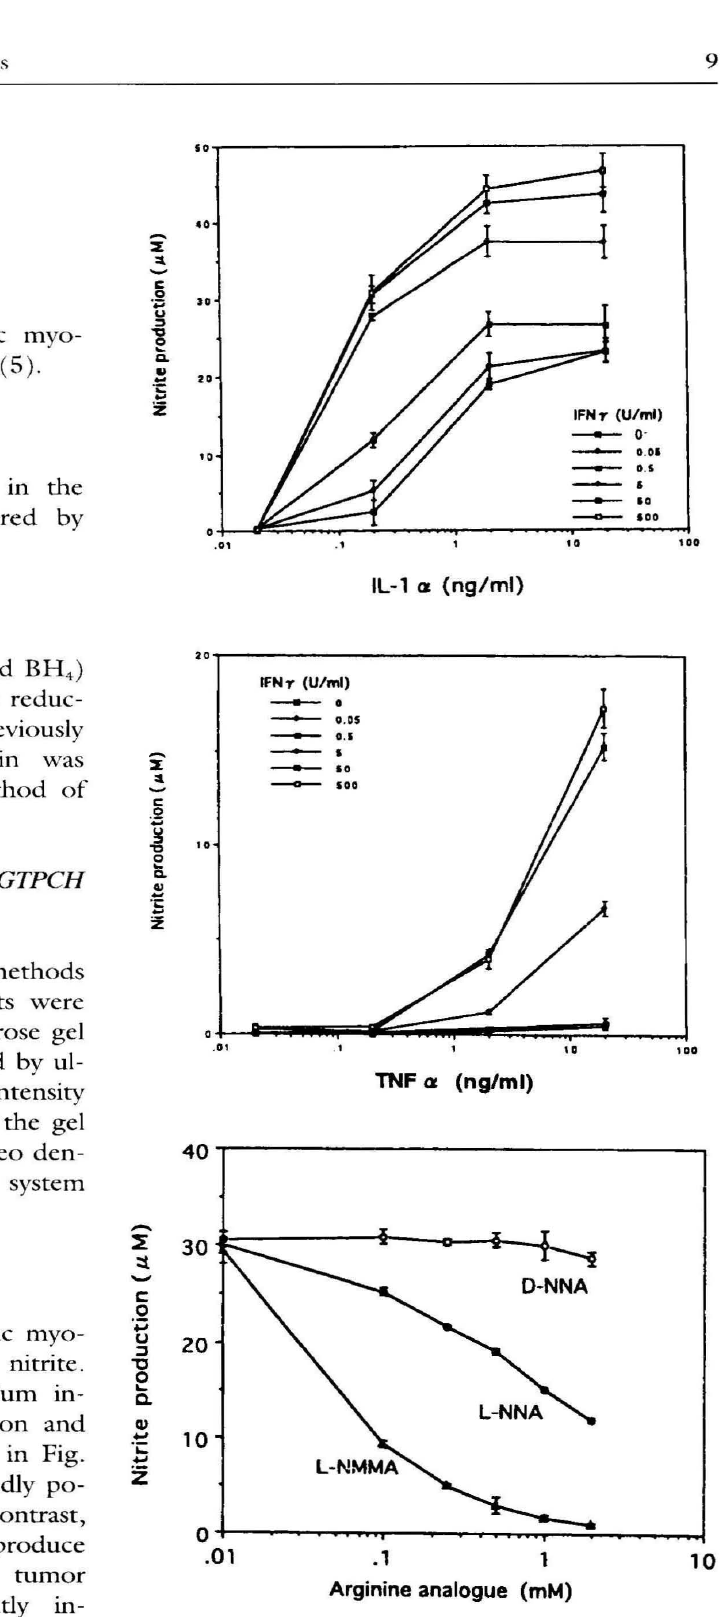
Figure 1. Activation of rat cardiac myocyte rutnte pro duction by (A) IL-1 and (B) TNF. (C) Effect of N"'-sub stituted arginine analogs on nitrite production by IL-1j IFN (24-h incubation). Each point represents the mean of four